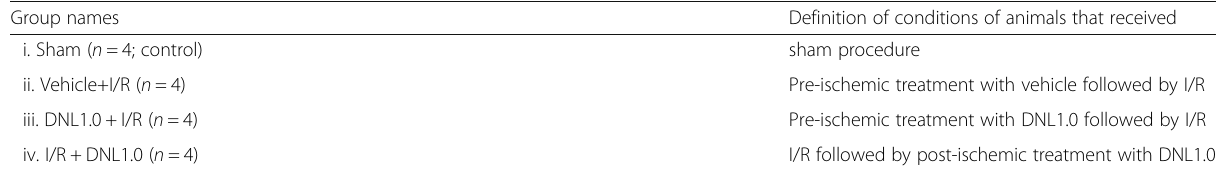
Table 4 Group names and definition of the conditions used to treat the various experimental groups of cells or animals. In vivo fluorogold RGC experiment